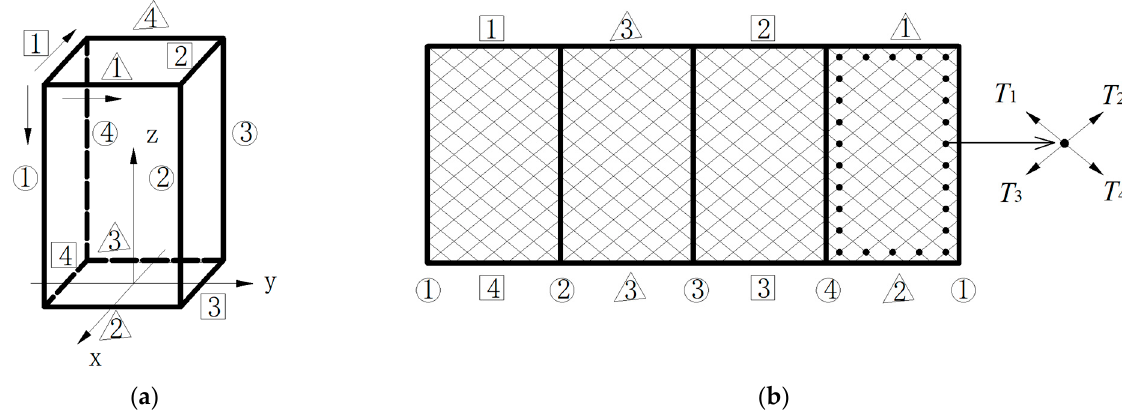
Figure 1. Unit division and force analysis of the floating frame.